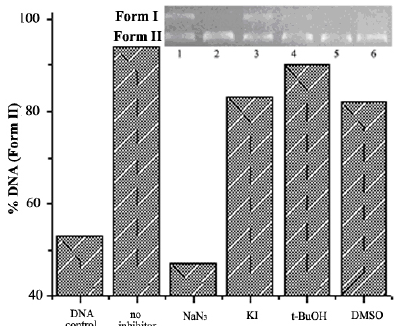
Figure 9. Histograms representing cleavage of pUC19 plasmid DNA (0.008 µg/µL) by compound 1b typical radical scavengers (3.13 × 10 − 4 mol/L, pH = 7.4). Lane 1: DNA control, Lane 2: no inhibitor, Lane 3: NaN 3 , Lane 4: KI, Lane 5: t -BuOH, Lane 6: DMSO.